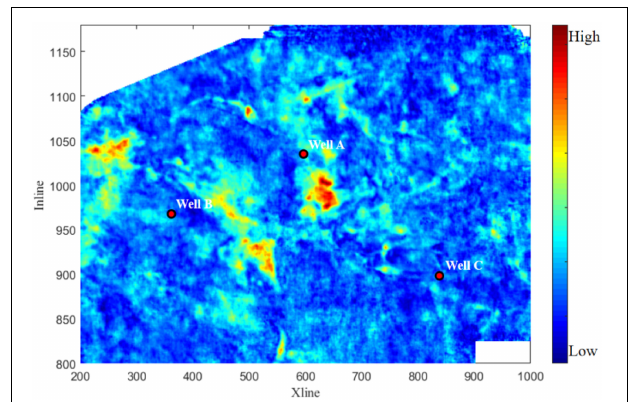
FIGURE 12 | Horizontal slice of the RMS amplitudes of the seismic reflection area.